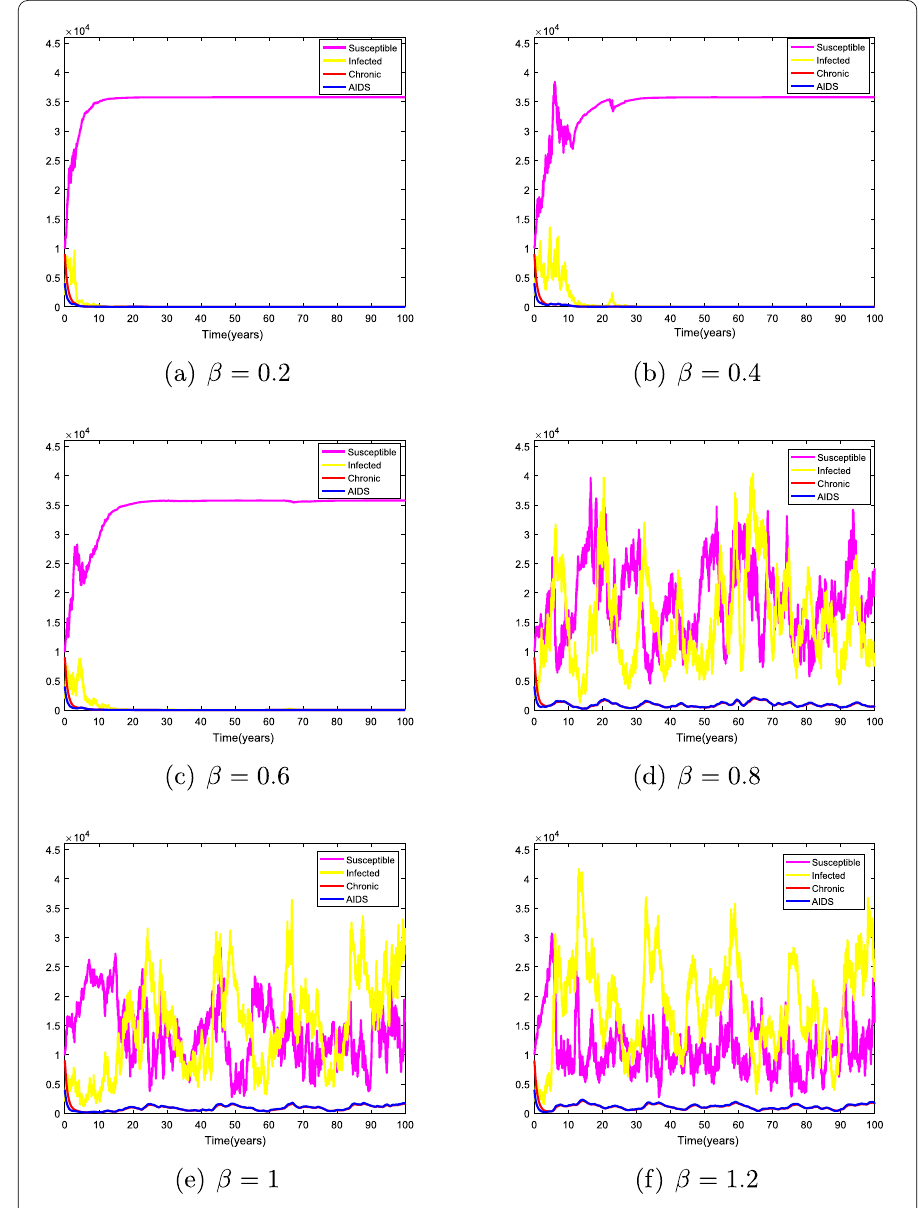
Figure 4 The path of ( S ( t ), I ( t ), C ( t ), A ( t )) for stochastic model (1.2) when σ =